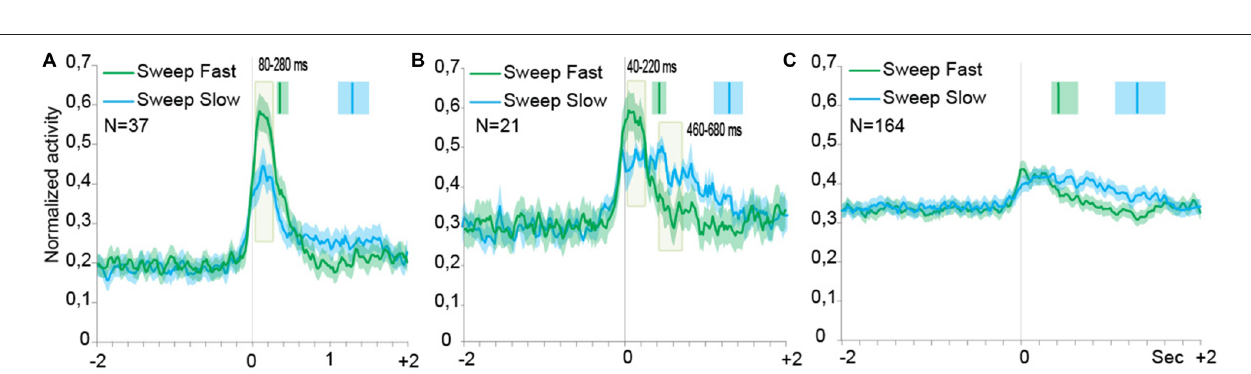
FIGURE 3 | Distribution of the R-square values of the SS and SU neurons showing significant correlation between the speed of the stimulus and the firing rate. The lines indicate the median value for the SS (in green) and SU neurons (in blue). In order to investigate the potential similarity between the speed/firing rate correlation of SS neurons and the correlation showed by the SU neurons, we compared the distribution of R-square obtained in the two groups. The Mann-Whitney U Test indicates that the R-square of the SS neurons (median = 0.33) is higher ( p < 0.001) than the R-square of the SU neurons (median = 0.18), thus speed variation account for a greater part of the variability of SS than SU neurons discharge.